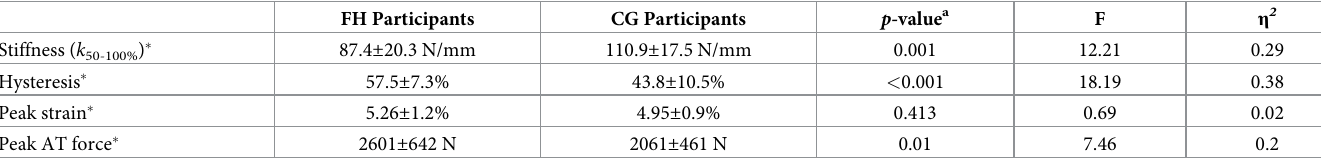
Table 1. Descriptive statistics and significance levels, F statistic and partial eta-squared for AT